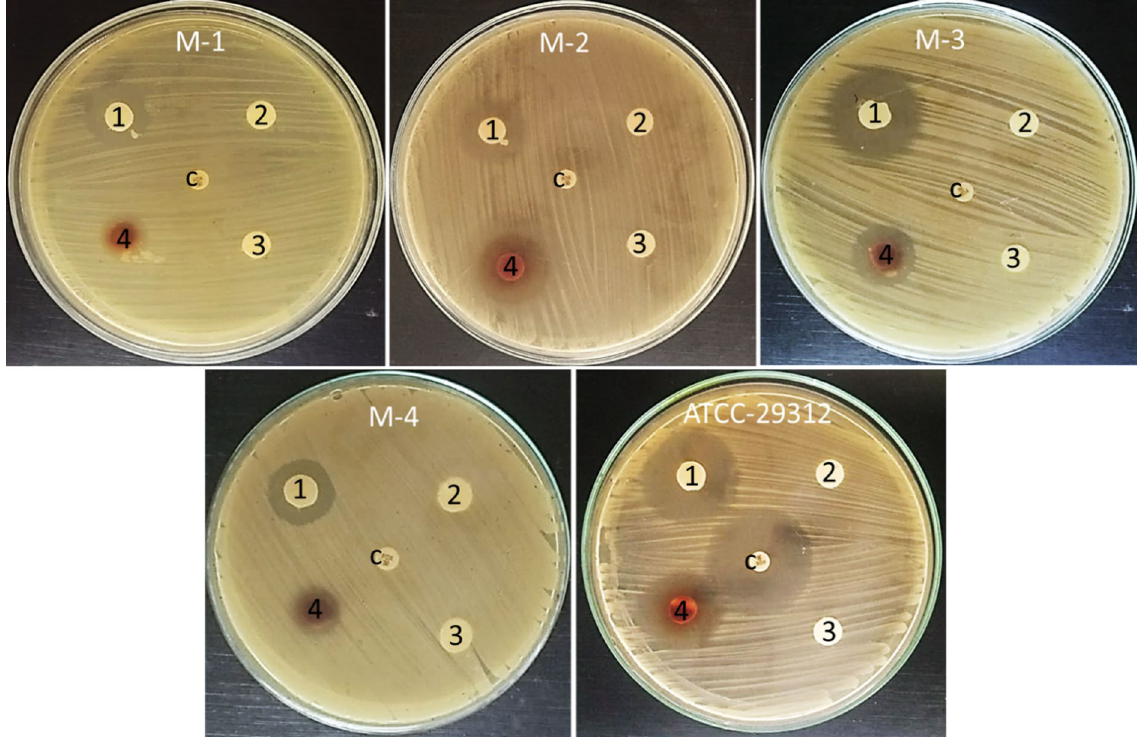
Figure 2. Antibacterial activity of saponin fraction (1), Phenolic fraction (2), Steroidal fraction (3), Crude extract (4), and cefoxitin (C) against MRSA isolates and Staphylococcus aureus ATCC